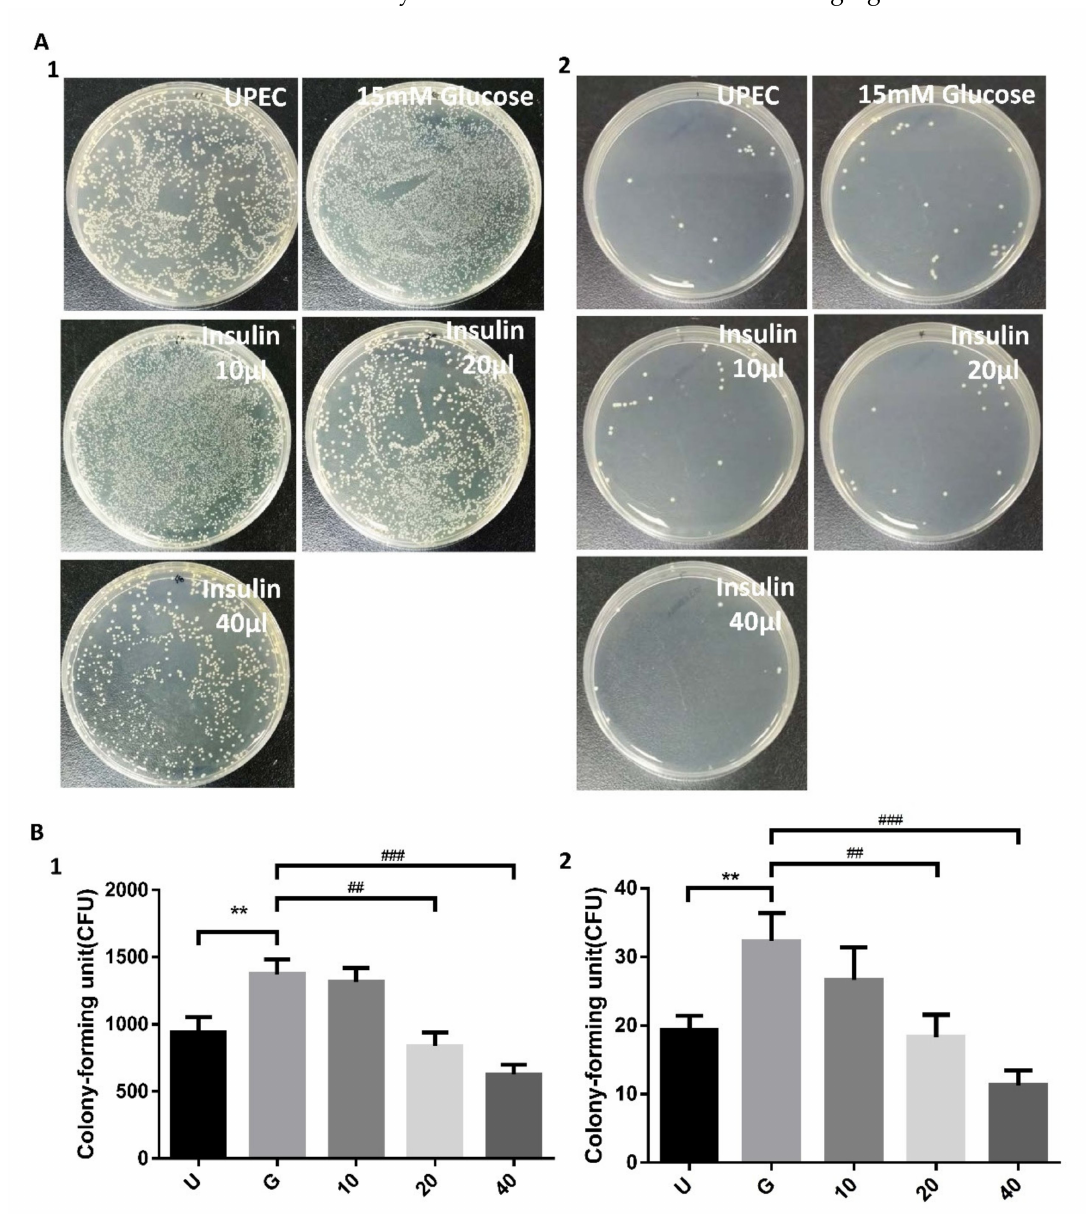
Figure 1. Influence of insulin on UPEC infection in bladder cells in a high glucose environment. SV-HUC-1 cells were pretreated with different concentrations of insulin and 15 mM glucose for 24 h and then infected with pGFP-UPEC (MOI:1:100) as described in the text. UPEC infection in bladder cells was examined by plating on NB medium agar ( A ) and determined using Image J software ( B ). Colony forming units (CFUs) were acquired after plating out lysed solutions of infected cells. The counting results of the lysate diluted 100 and 10,000 times were shown in ( A1 ), ( B1 ) and ( A2 ), ( B2 ), respectively. Data are expressed as the mean ± SD of three independent experiments. The definitions of each letter/number represented by the X axis are: U: UPEC infection alone; G: with 15 mM glucose pretreatment; 10, 20 and 40: pretreated with 10, 20 and 40 µ g/mL insulin, respectively + 15 mM glucose. ** p < 0.01, compared with the infection control group. ## p < 0.01, ### p < 0.001, compared with the 15 mM glucose pretreated